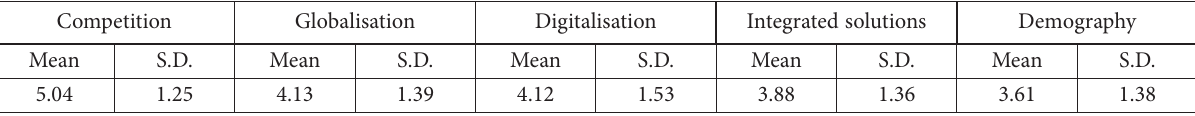
Figure 3. Ownership ratios differentiated over time and according to use type Table 6. Descriptive evaluation of the relevance of the drivers of structural change to the real estate economy